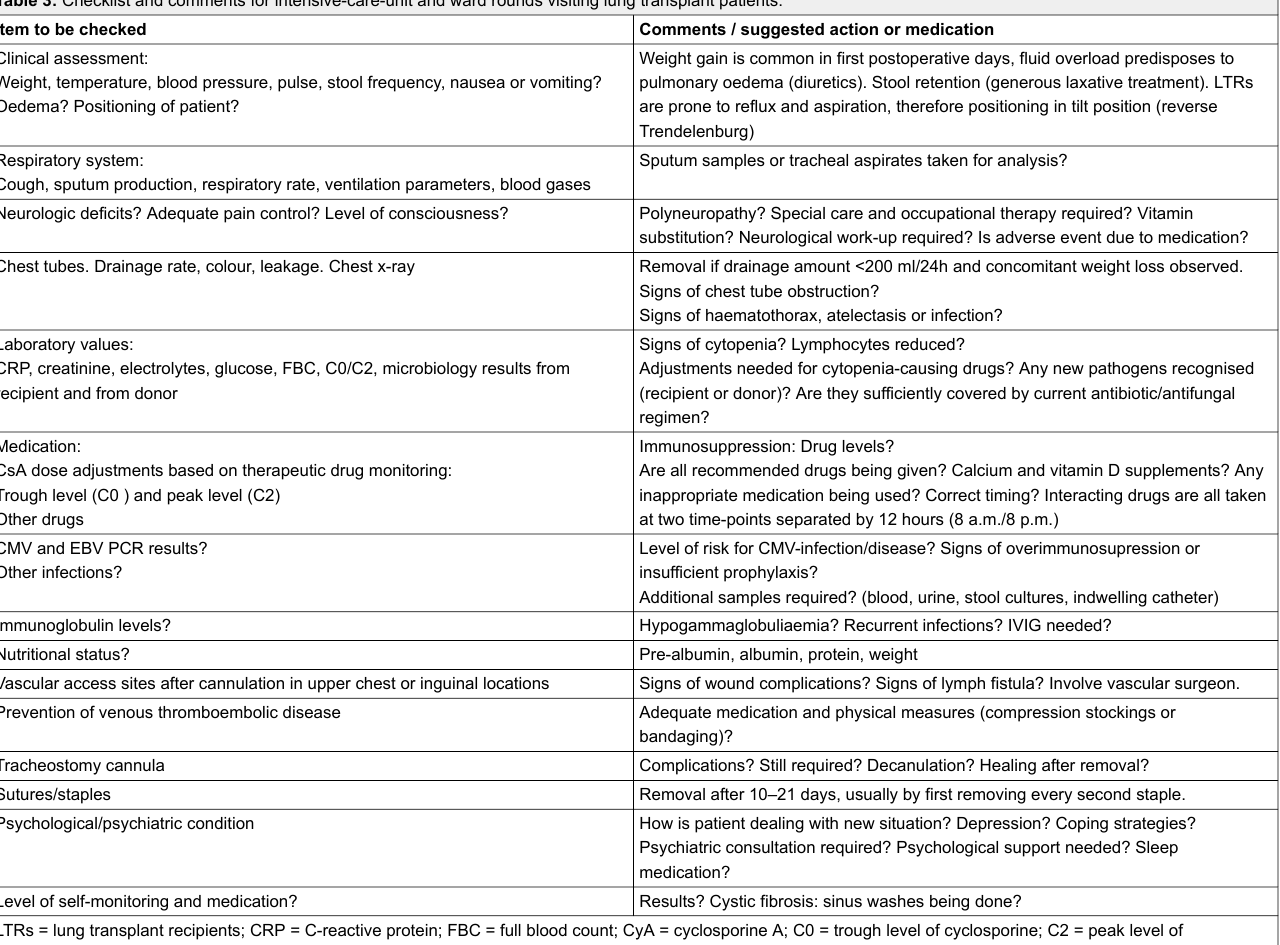
Table 3: Checklist and comments for intensive-care-unit and ward rounds visiting lung transplant patients. Item to be checked Comments / suggested action or medication Clinical assessment: Weight, temperature, blood pressure, pulse, stool frequency, nausea or vomiting? Oedema? Positioning of